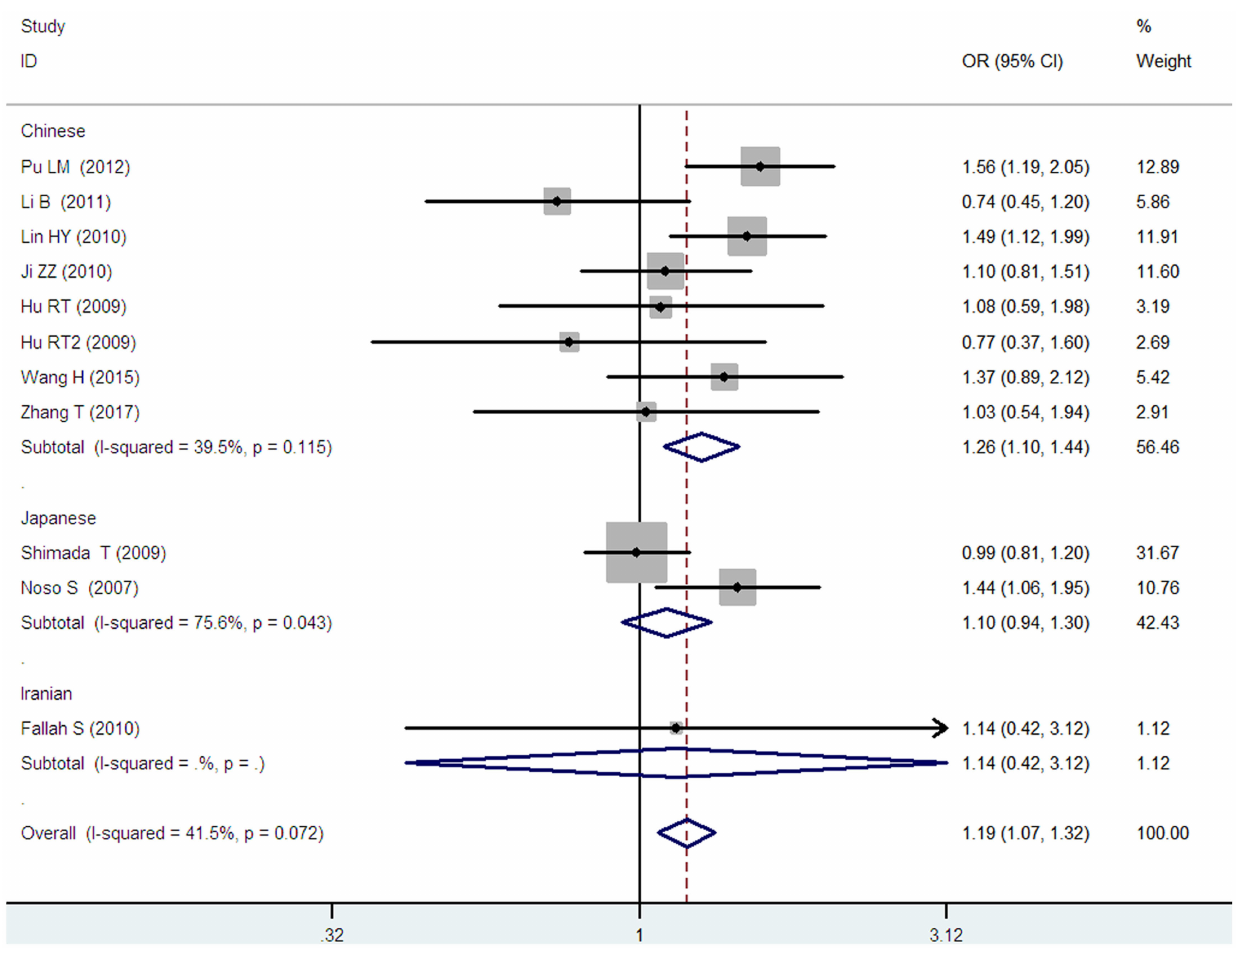
FigUre 5 | Forest plot of type 2 diabetes mellitus associated with small ubiquitin-like modifier 4 gene M55V polymorphism under a heterozygous genetic model (MV vs.